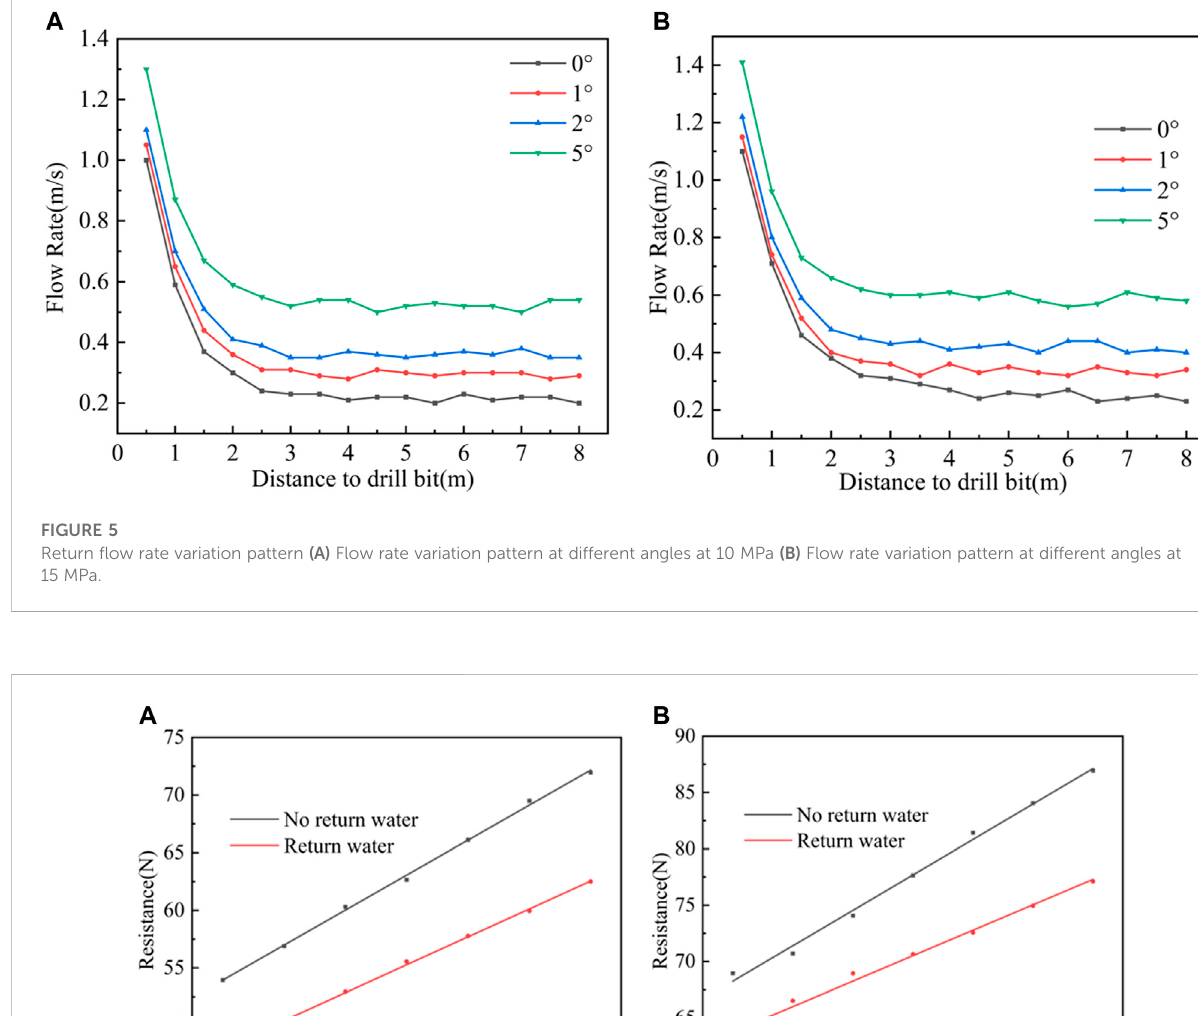
Frontiers in Earth